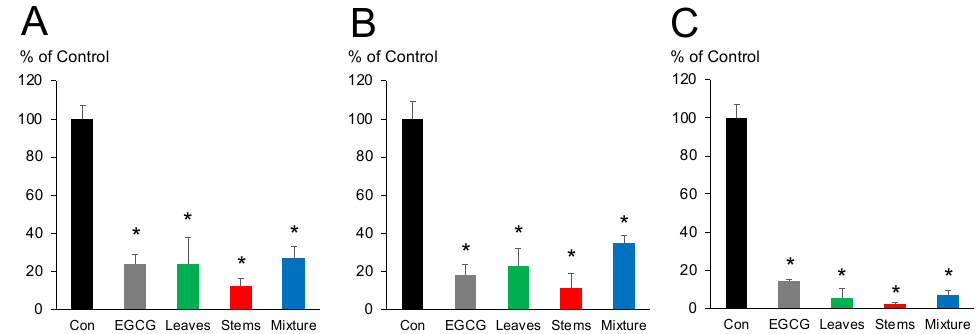
Figure 2. The inhibitory effects of water extracts of V. virgatum leaves, stems, and leaf/stem mixtures against three ATL cell lines: ( A ) ED, ( B ) S1T, and ( C ) Su9T01. The data are mean ± SD for 10 individual samples. Statistical significance was evaluated using unpaired two-tailed Student’s t -tests (* p < 0.05). Con; Control, EGCG; epigallocatechin gallate.